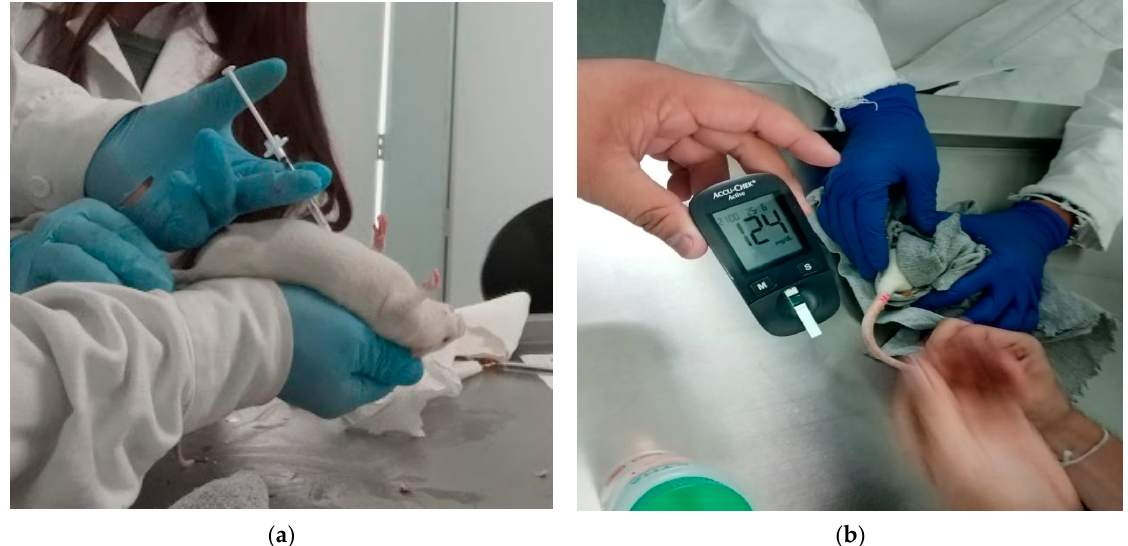
Figure 14. ( a ) STZ administration through the intraperitoneal. ( b ) Glucose levels greater that 120 mg/dL are indicative of animals with diabetes.